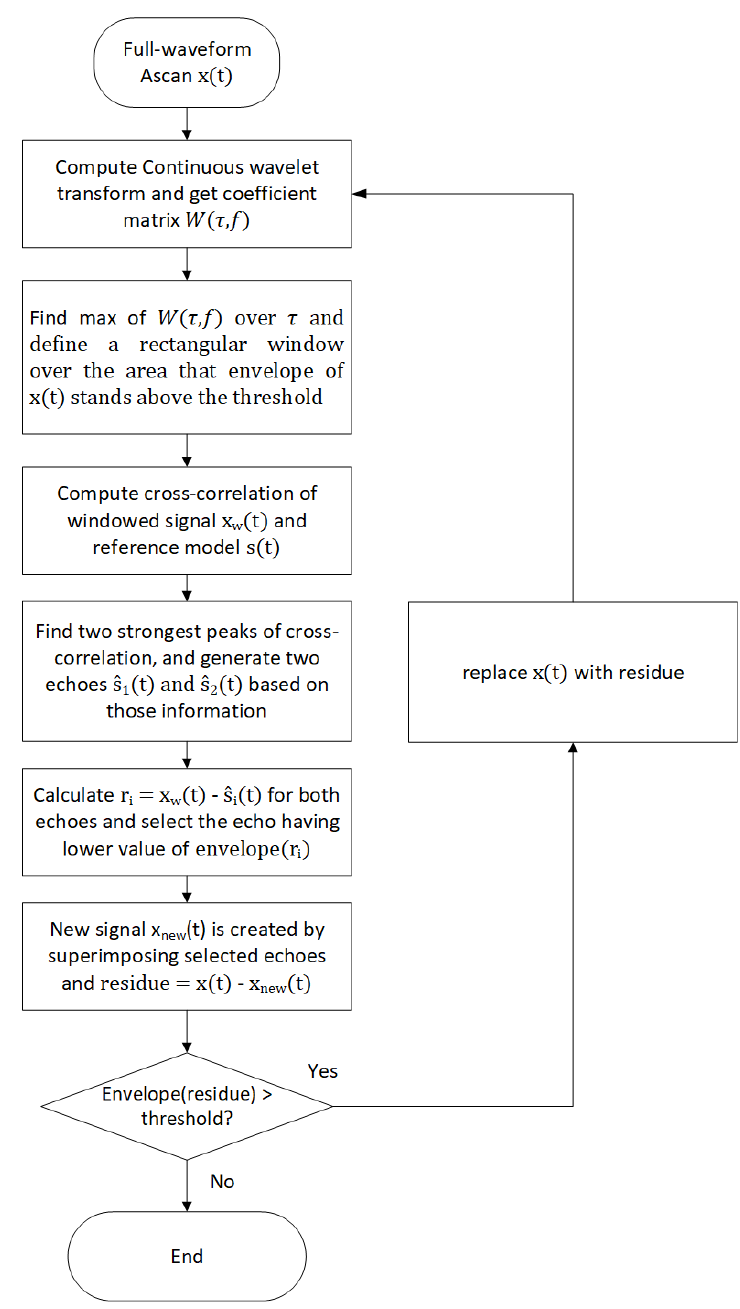
Figure 6. Flowchart of the modified echo localization algorithm. We note that the reference echo model and the threshold are provided as input for this